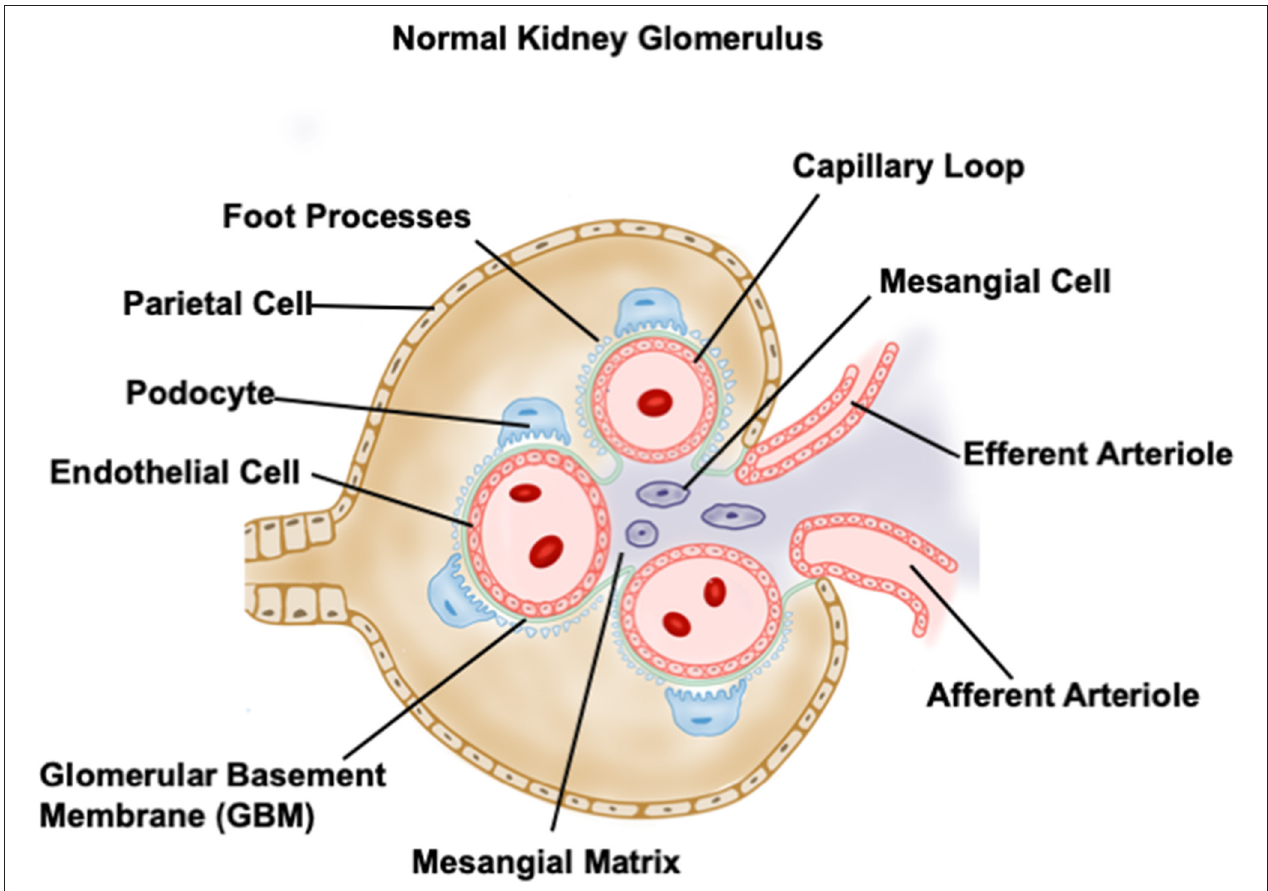
FIGURE 2 | Diagrammed normal glomerular